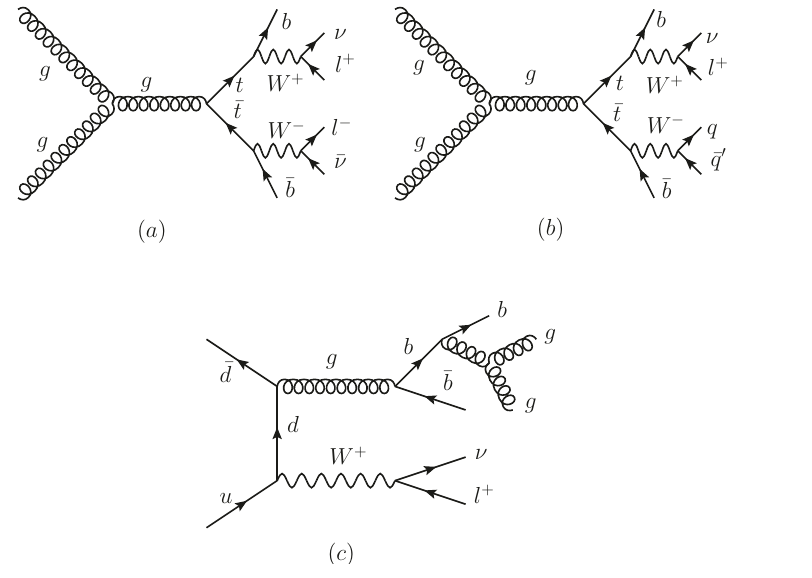
Figure 17 . Feynman diagrams for (a) leptonic t (cid:22) t , (b) semi-leptonic t (cid:22) t and (c) Wb (cid:22) b + jets back- ground for the b (cid:22) bWW (cid:3) channel. Here, l refers to e; (cid:22) and (cid:28)